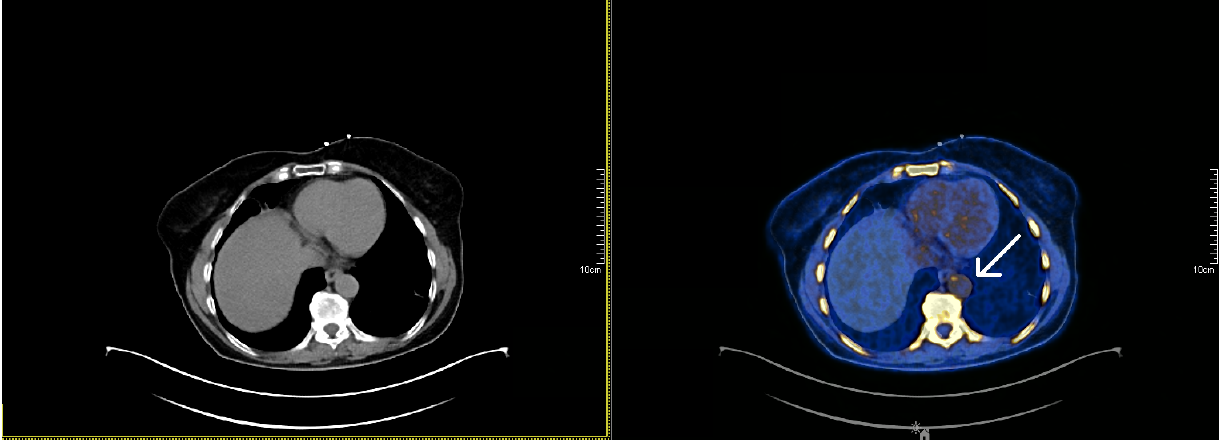
Figure 1. Fusion 18F-NaF-PET-CT images, depicting NaF uptake in the descending aorta (arrow, right picture). In the left picture, corresponding to the raw CT image, one can observe that the NaF uptake matches an area without macroscopic calcification. NaF was injected 60 min before image acquisition. Image source: Institute for Nuclear Sciences Applied to Health (ICNAS).